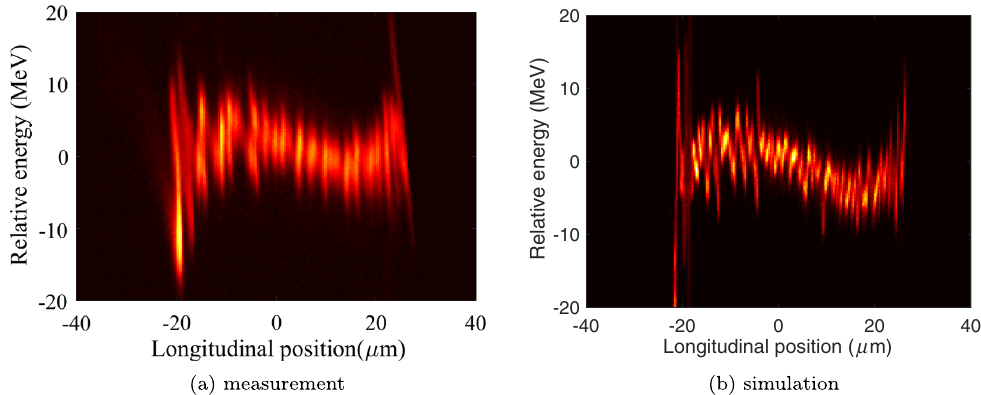
FIG. 5. Measurement (left) and simulation (right) of the final longitudinal phase space distribution with the laser heater off. Beam current is 1 kA, with bunch charge 180 pC. The bunch head is to the